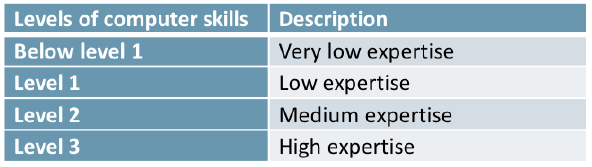
Table 6: Levels of computer skills.